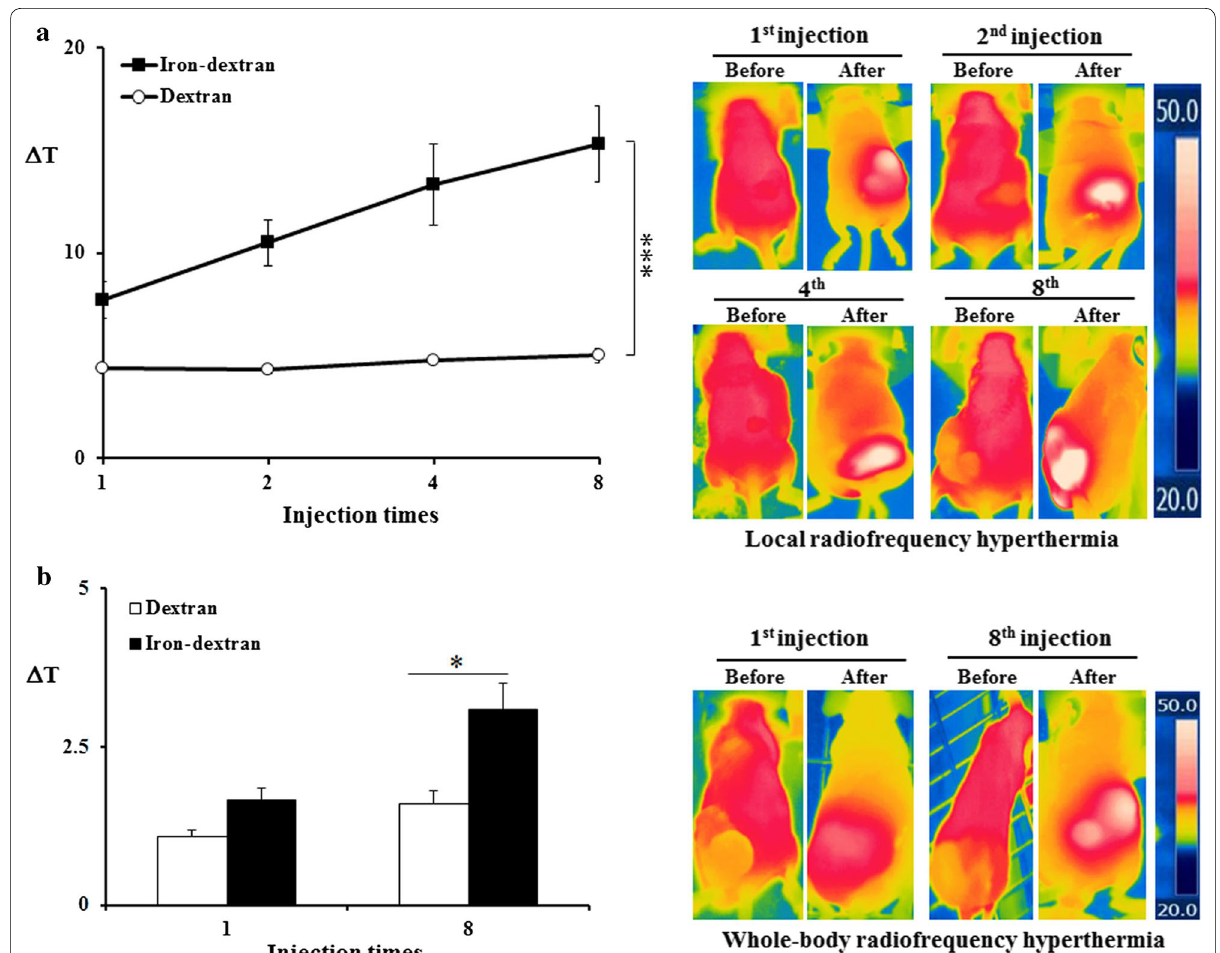
Fig. 3 The tumor tissues became more reactive to 13.56 MHz RF hyperthermia as i.v. injection of iron‑dextran. a The repeated i.v. injection of iron‑dextran to cancer‑bearing mice boosted temperature elevation greater in a local 13.56 MHz RF hyperthermia as iron ion concentration was increased by repeated injections. b The repeated i.v. injection of iron‑dextran boosted temperature elevation in a whole‑body 13.56 MHz RF hyperthermia as iron ion accumulated. The values represent the mean * p < 0.05, *** p <